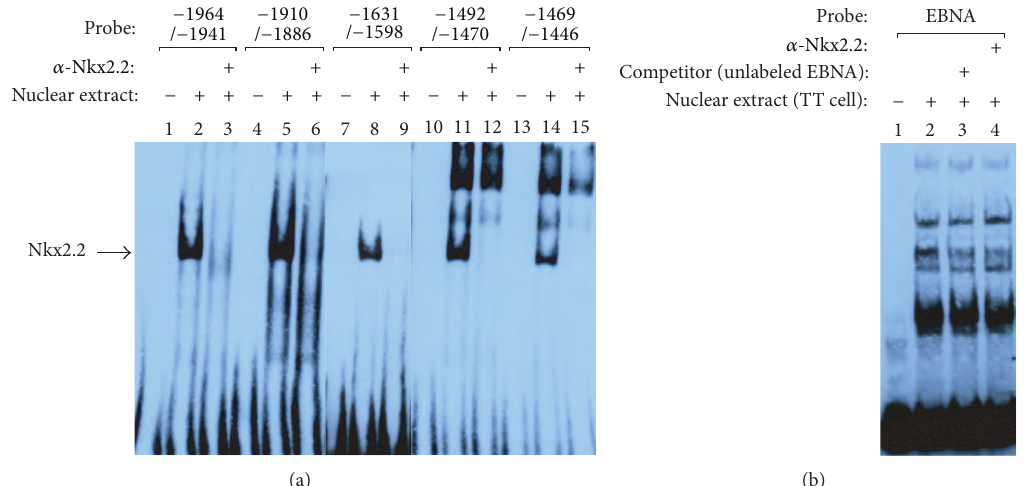
Figure 8: EMSA of Nkx2.2-binding to the human ghrelin gene promoter. (a) Nuclear extracts were prepared from TT cell. The specific complex formed from TT cell nuclear extract and a candidate Nkx2.2 binding element is indicated by an arrowhead. (b) EBNA was used as the control for specific binding of Nkx2.2 antibody. Super shift assay experiments were performed using 1 𝜇 g (200 𝜇 g/0.1 mL) of Nkx2.2 (H-60) antibody (lanes 3, 6, 9, 12, and 15 in ghrelin promoter assay and lane 4 in control EBNA).